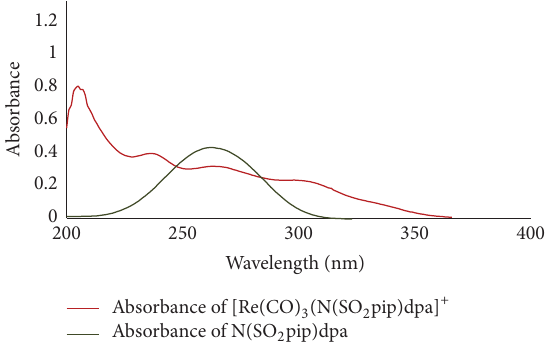
Figure 3: UV-visible spectra of N(SO 2 pip)dpa and [Re(CO) 3 (N(SO 2 pip)dpa)] +